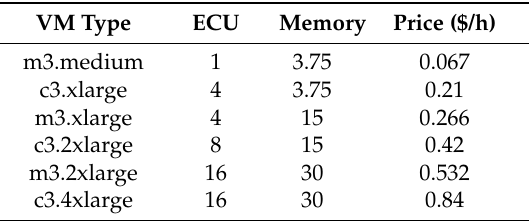
Table 3. VM types specifications. ECU: EC2 Compute